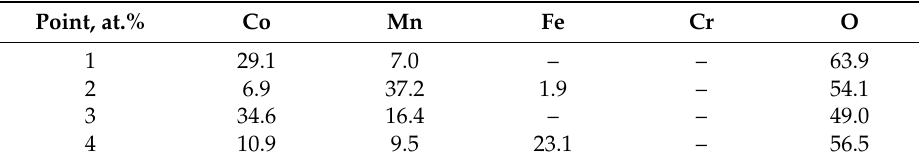
Figure 6. Cross-section morphology and EDS line scanning of Co-40Mn coating oxidized at 750 °C in air for 100 h. The line scan position is shown in the cross-sectional image. Table 4. Composition analysis by EDS of the local region in Figure